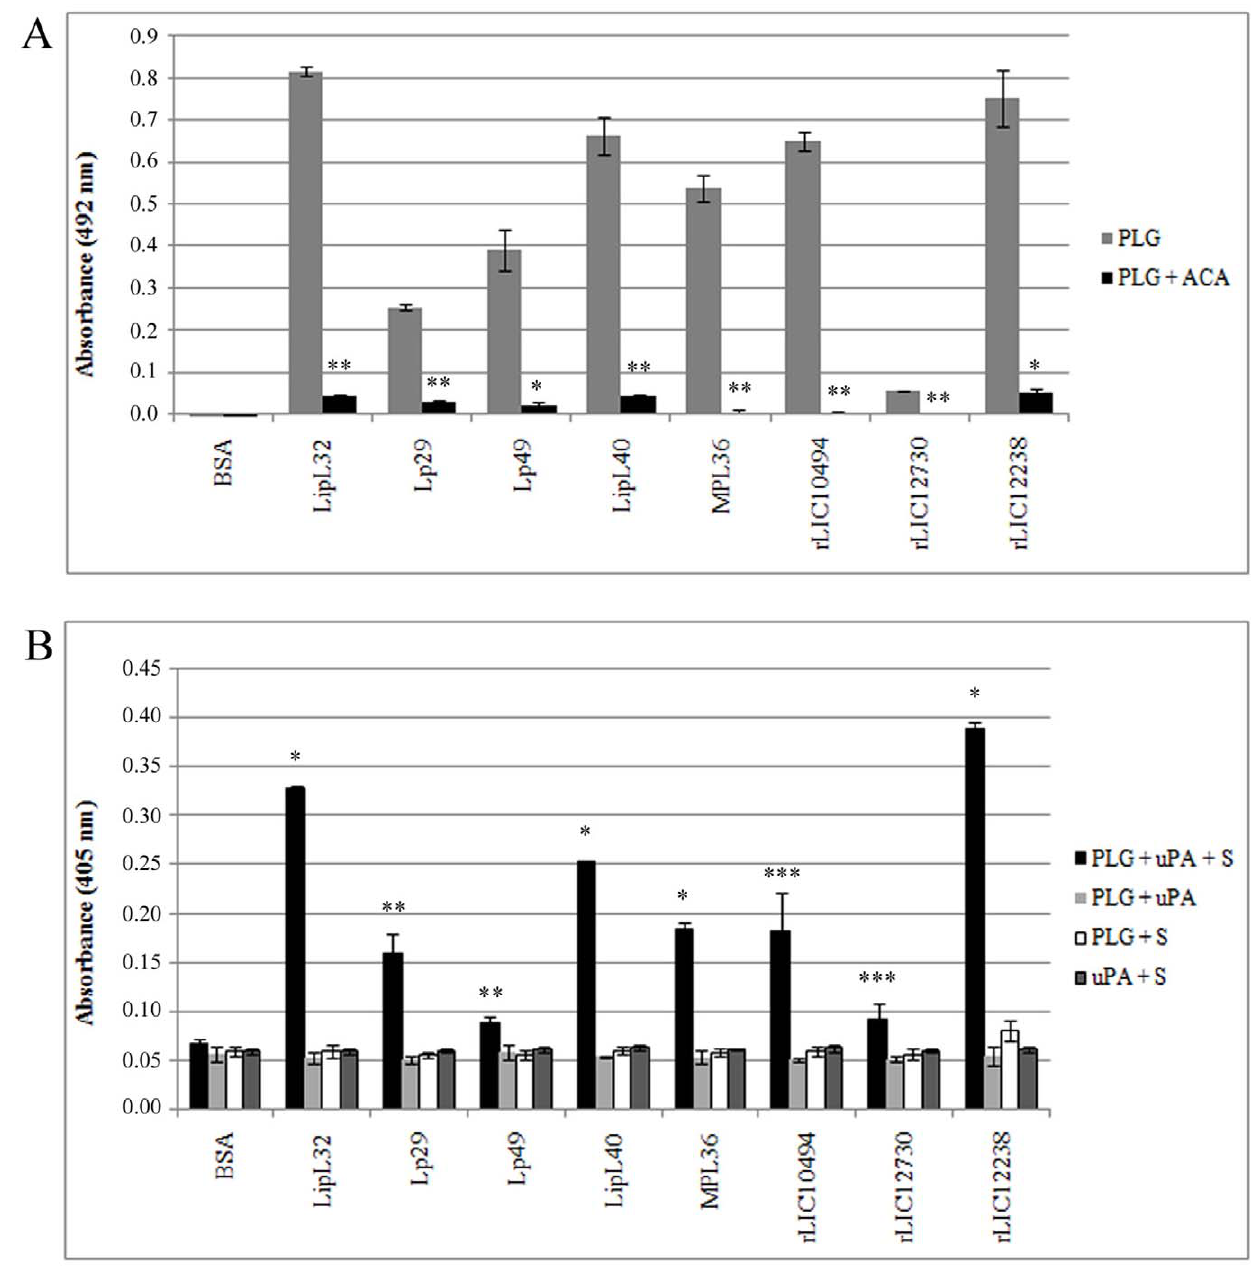
Figure 4. Role of lysine residues in recombinant protein-PLG interaction and activation to enzymatically active plasmin. A: Binding of the immobilized proteins LipL32, Lp29, Lp49, LipL40, MPL36, rLIC10494, rLIC12730 and rLIC12238 (10 m g/ml) to PLG (10 m g/ml) was carried out in the presence (PLG + ACA) or absence (PLG) of the lysine analogue 6-aminocaproic acid. BSA was used as a negative control for nonspecific binding. The bound PLG was detected and quantified by specific antibodies. Bars represent the mean absorbance at 492 nm 6 the standard deviation of four replicates for each sample and are representative of two independent experiments. Statistically significant differences are shown by * ( P , 0.001) and ** ( P , 0.0001). B: Cleavage of specific plasmin substrate by PLG bound to recombinant proteins was assayed by modified ELISA as immobilized proteins received the following treatment: PLG + uPA + specific plasmin substrate (PLG + uPA + S), or controls lacking one of the three components (PLG + uPA; PLG + S; uPA + S). BSA was employed as a negative control. Bars represent the mean absorbance values at 405 nm, as a measure of relative substrate cleavage, 6 the standard deviation of four replicates for each experimental group and are representative of two independent experiments. Statistically significant differences are shown by * ( P , 0.00001), ** ( P , 0.005) and *** ( P , 0.05). evidence that heparin dextran derivatives could contribute to the addition of Cl 2 did not inhibit LipL32 or rLIC12238-PLG regulation of plasmin activity, not only by impeding plasmin interactions, showing in fact, a positive effect with increasing generation, as a result of their binding to plasminogen but also by sodium chloride concentration. The presence of heparin had no directly affecting the catalytic activity of the enzyme [48]. The influence on the binding of either protein to PLG. Similar results